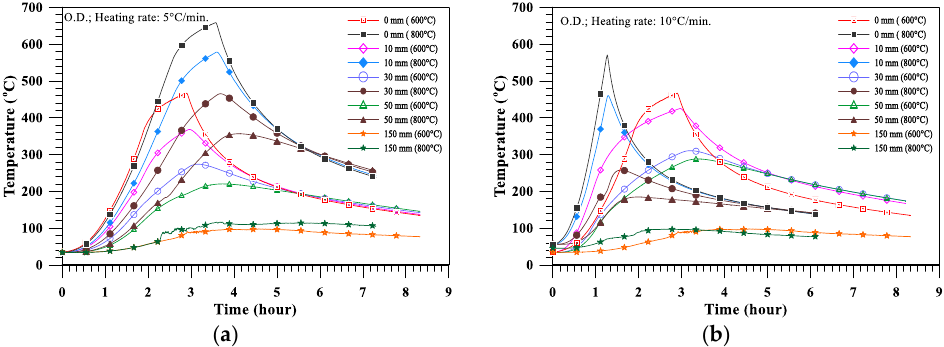
Figure 8. Comparison of the temperature distributions of the oven-dried LWAC specimens: ( a ) heat- ing rate of 5 °C/min; ( b ) heating rate of 10 °C/min.